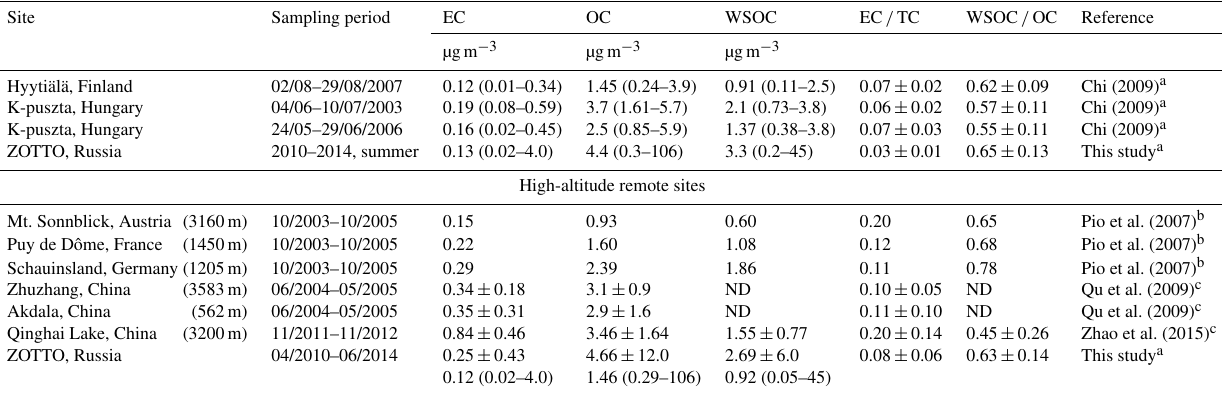
Table 1. Mean (with ± SD, where available) and median (min–max) concentrations (µgm − 3 ) of EC, OC, and WSOC, together with EC / TC and WSOC / OC ratios measured at remote background sites compared with ZOTTO data obtained from April 2010 to June 2014. ND: no